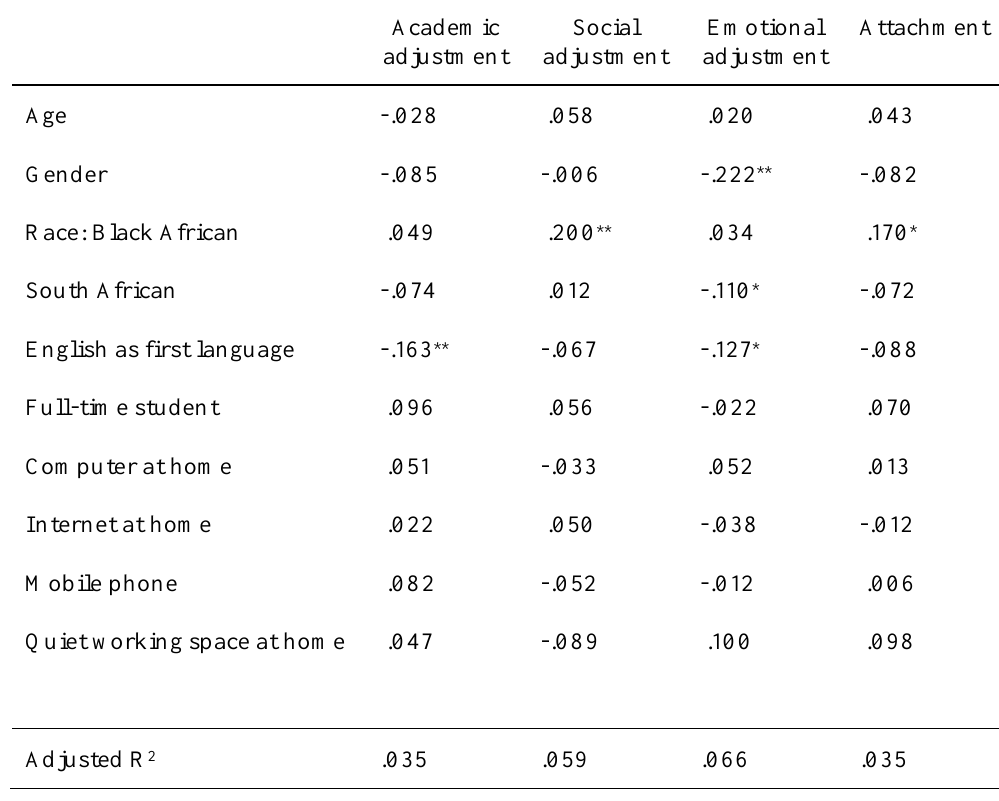
Regression Analyses of SACQ Scales and Demographic Variables (Standardised Beta Coefficients)